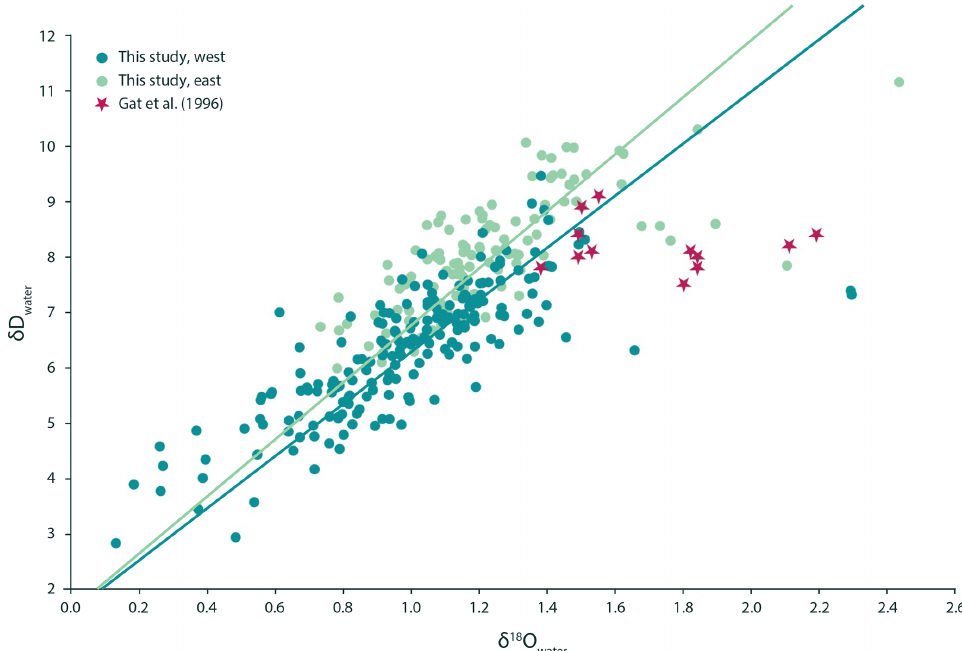
Figure 1. The δ D of the Mediterranean surface seawater is positively correlated with the local δ 18 O. The orthogonal regression of the western Mediterranean can be described as δ D water = 4 . 72 × δ 18 O water + 1 . 67 (dark green). The eastern Mediterranean is very similar to the western basin, and the relationship between seawater δ 18 O and δ D is δ D water = 5 . 19 × δ 18 O water + 1 . 68 (light green) here. Statistically they cannot be told apart. This was determined using a bootstrapping approach that generated 100 slopes and intercepts for both the eastern and the western dataset and subsequent t testing using the mean and standard deviation of both groups of slopes and intercepts, which resulted in p values > 0.05. In both areas, the relationship is different from the observations made by Gat et al. (1996), whose dataset suggested no statistically significant relationship between δ D and δ 18 O of the seawater ( p value >